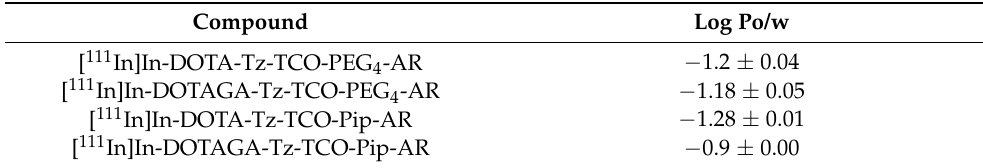
Table 2. Partition coefficients (log Po/w) of the four 111 In-radioconjugates ( n = 3 or 4). Compound Log